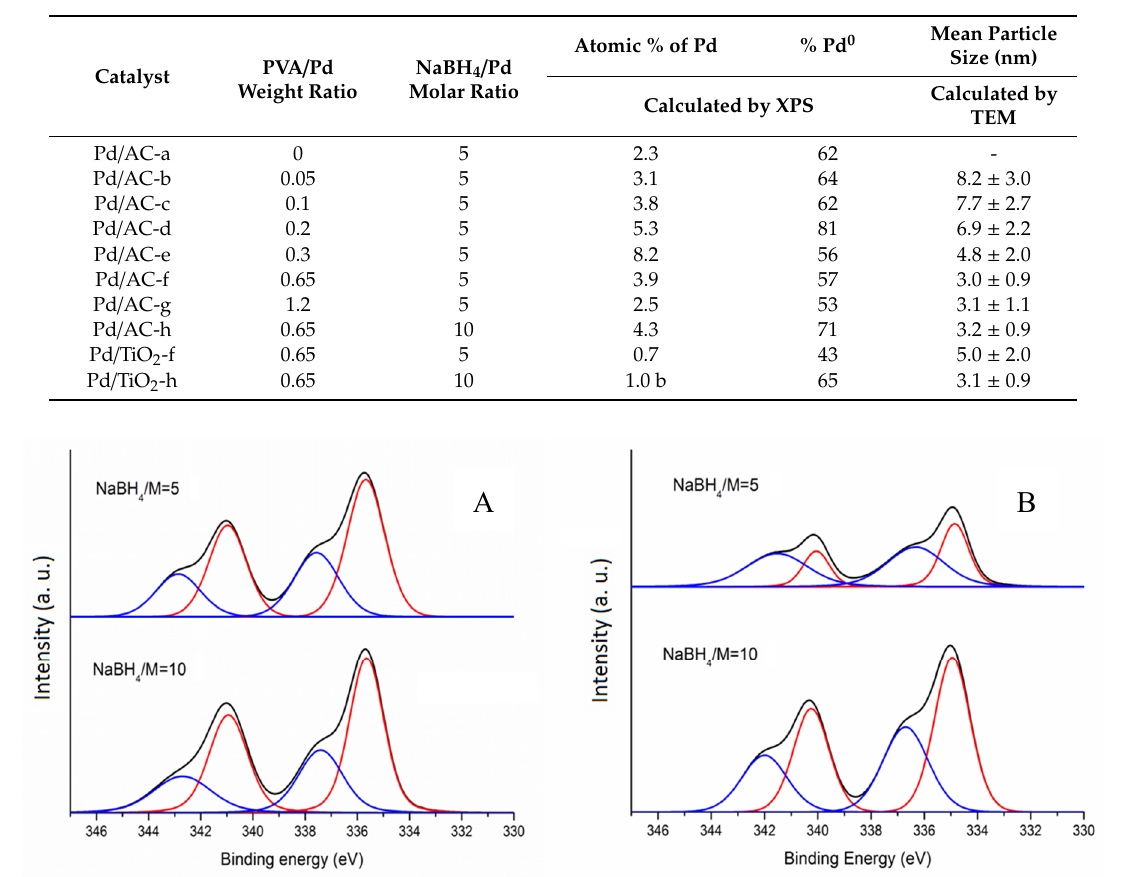
Table 1. Palladium atomic content at the surface, % Pd 0 and mean particle size.